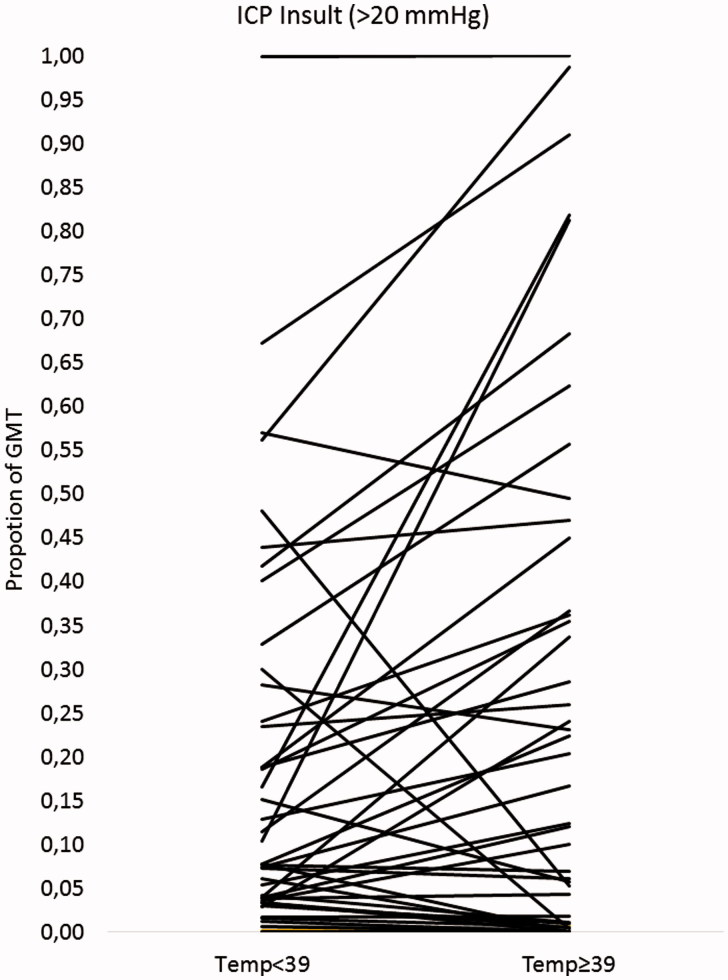
The occurrence of intracranial pressure (ICP) > 20 mmHg (in proportion of good monitoring time [GMT]) compared between periods in the highest temperature range (temperature ≥39 °C) and periods in the lower ranges (temperature <39 °C) for individual patients (25 patients with time in both temperature ranges). Each line with dots represents one patient.